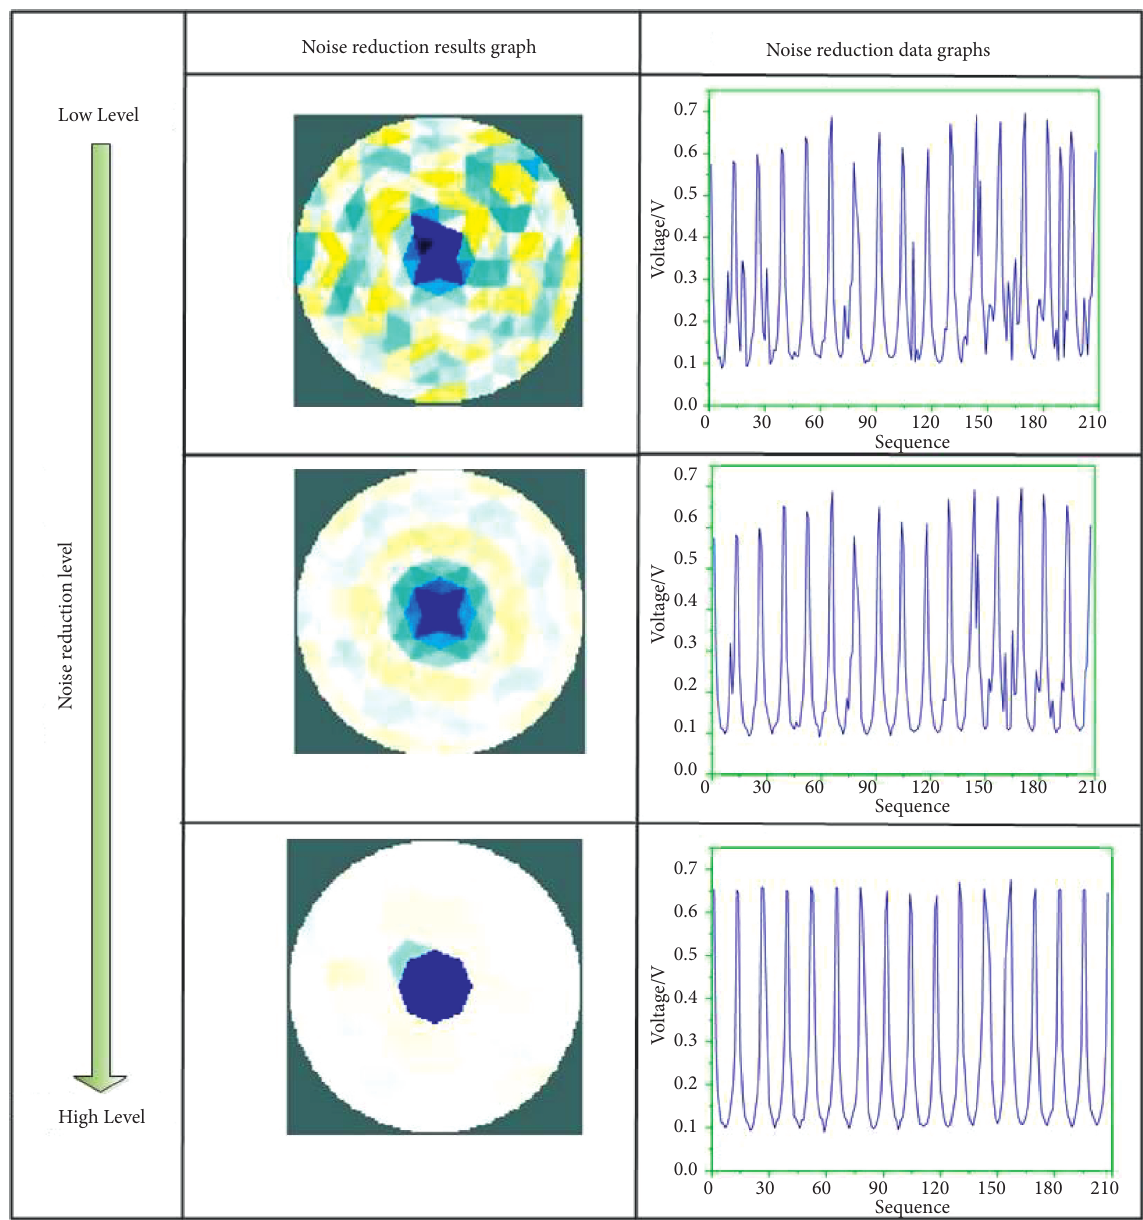
Figure 10: 16-electrode disc noise reduction results reconstructed image. Figure 13 shows the schematic diagram of the excitation and measurement modes. Among them, Figure 13(a) is the schematic diagram of adjacent excitation adjacent measurement; Figure 13(b) is the schematic dia- gram of interval excitation reference measurement. A mode of excitation current mostly passes through the field’s boundary only, and the distribution of equipotential lines in the sensitive area is not uniform. B mode of excitation current passes through the centre of the field, the uniformity of current distribution is enhanced, and the amplitude of voltage value change is more significant, which is beneficial to measure the voltage signal and improve the quality of inversion imaging.